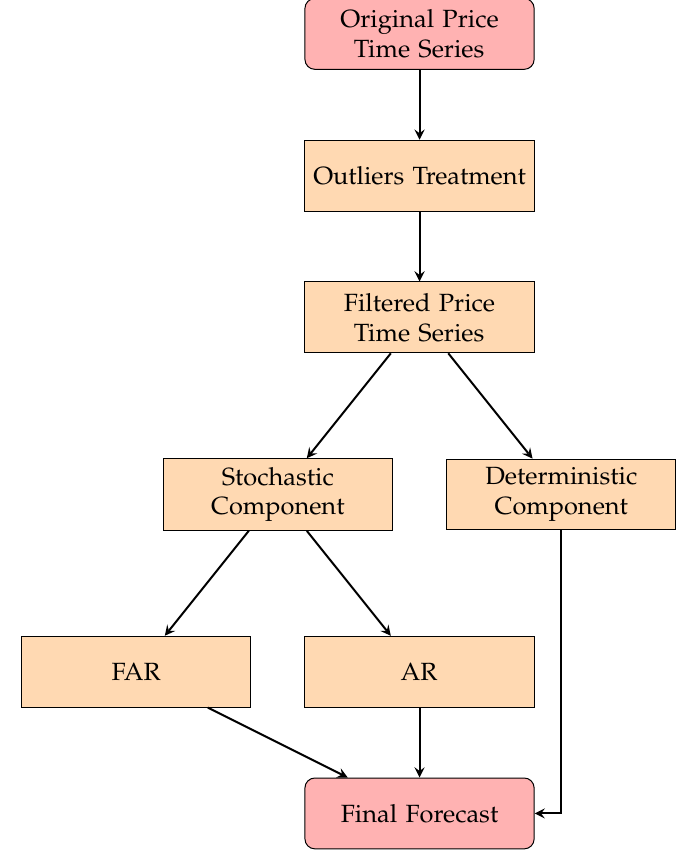
Figure 1. Flowchart of the proposed modeling